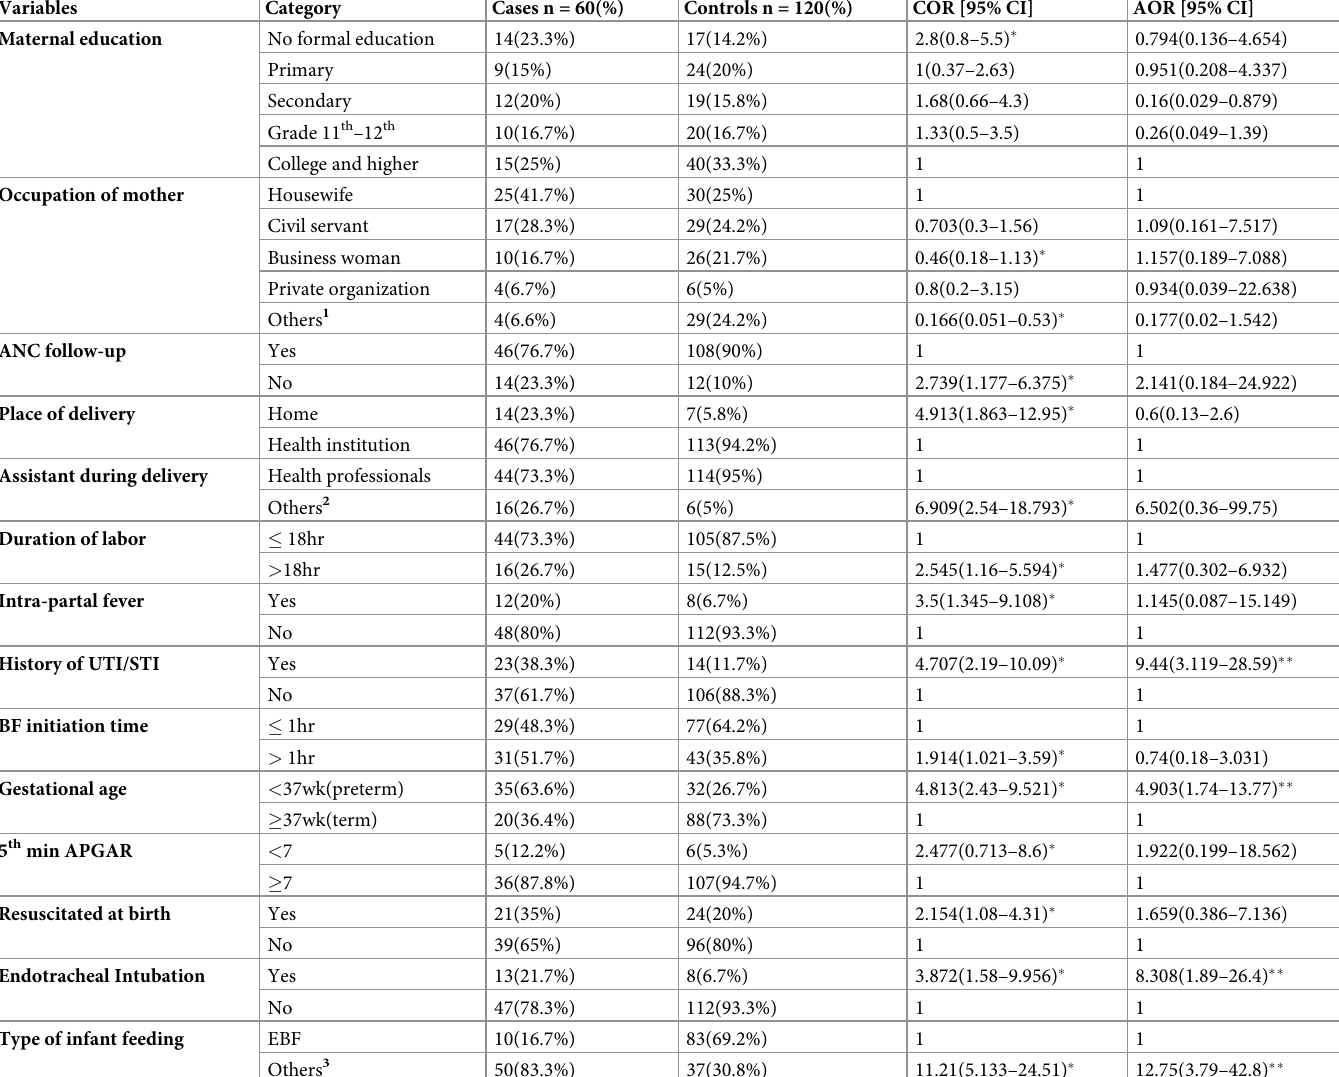
Table 4. Bivariate and multivariable logistic regression analysis result of determinant variables of late-onset neonatal sepsis admitted to NICU of Arbaminch gen- eral Hospital, Gamo zone, Ethiopia.